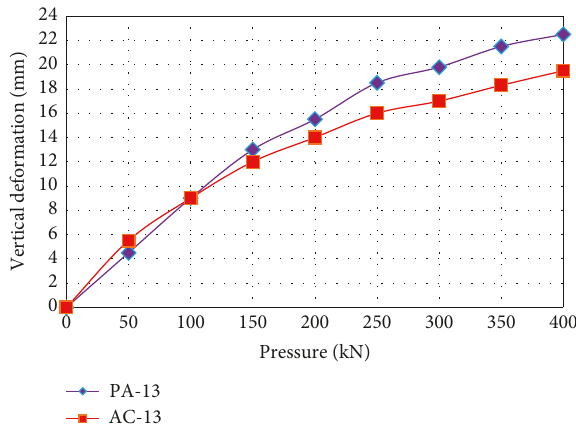
Figure 4: Measured vertical deformation to pressure of graded